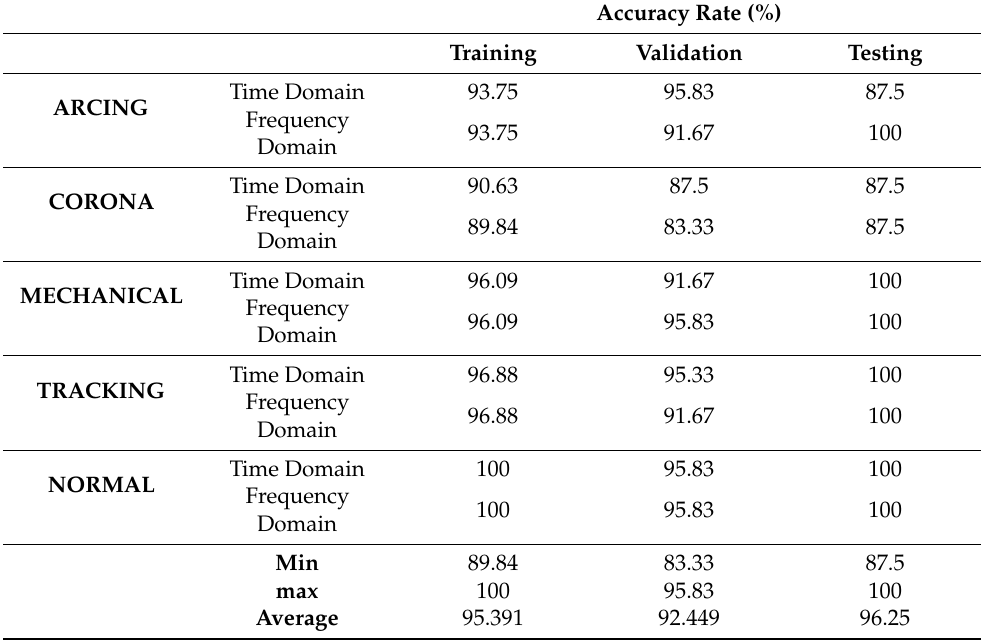
Table 14. Summary classification output of different switchgear faults in accuracy rate.